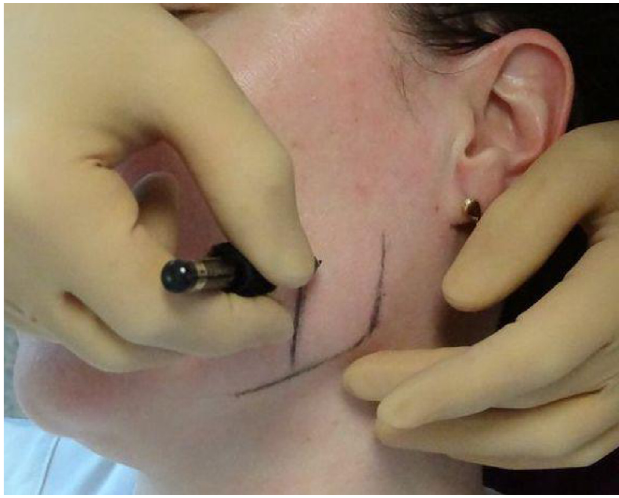
Fig. 3. Masseter muscle palpated and marked before injecting botulinum toxin into a patient with bruxism (credit: Dr.